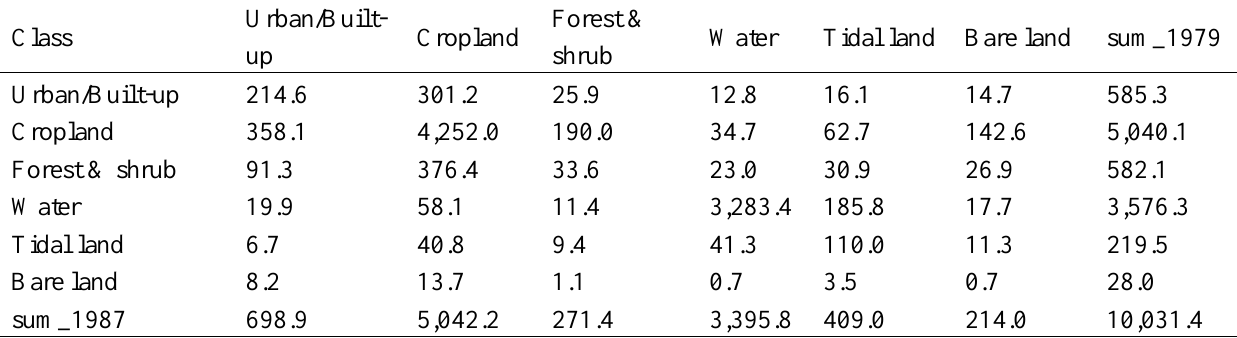
Table 5. Land use transformation matrix in 1979–1987 (unit: km 2 ).